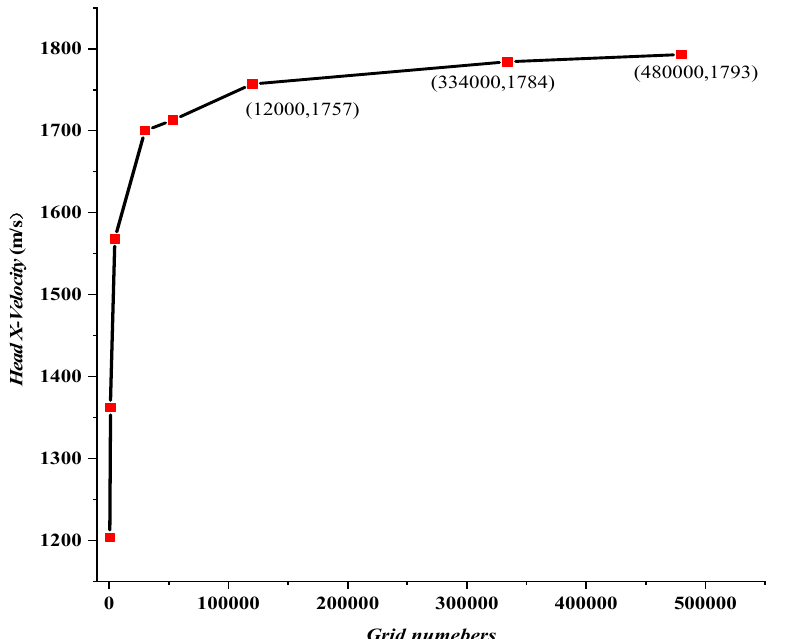
Figure 5. Comparison of experimental results [39] and numerical simulation.